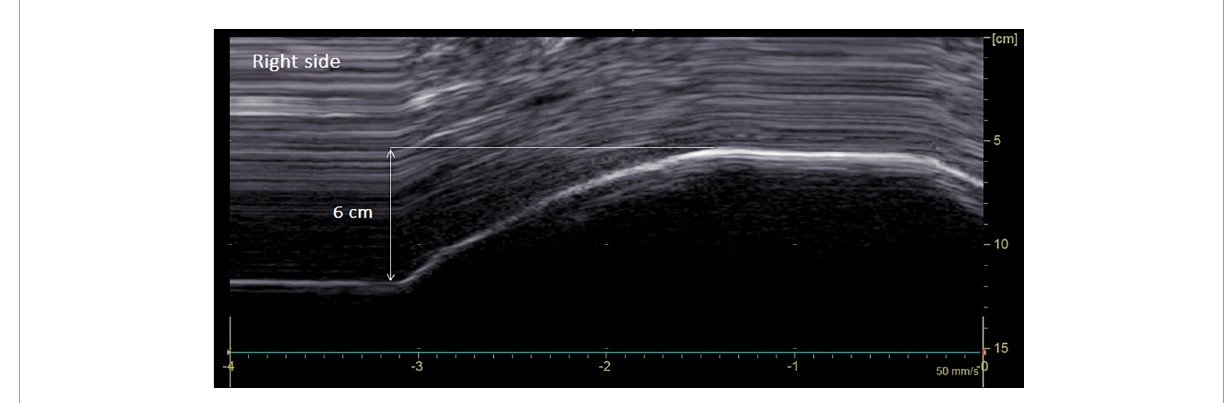
FIGURE2 Diaphragmatic motion recorded by M-mode ultrasonography in a man suffering from left hemidiaphragm dysfunction. Hemidiaphragm excursions were measured by placing the first caliper at the foot of the inspiration slope on the diaphragmatic echoic line and by placing the second caliper at the apex of the curve (see arrow). On the right side : normal excursion during deep breathing (6 cm for a lower limit of normal = 4.1 cm).